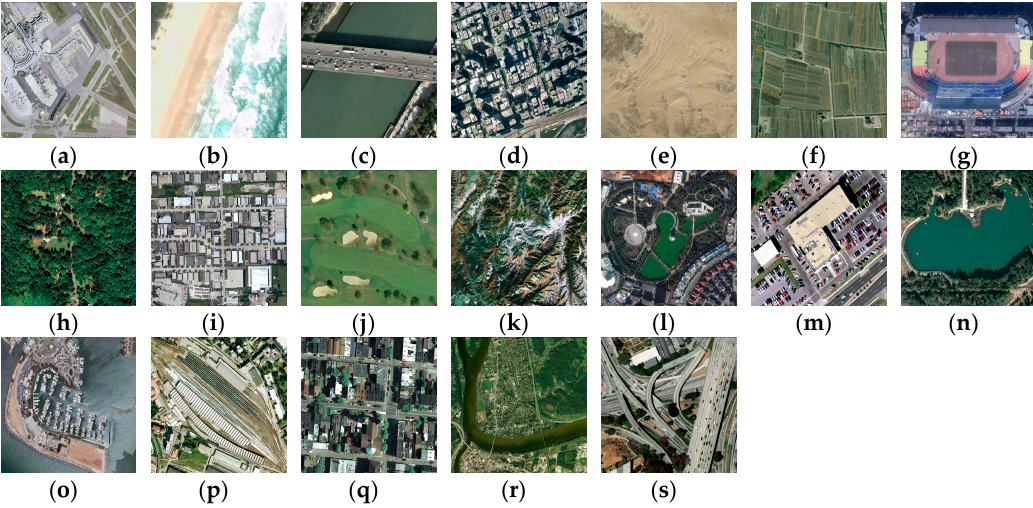
Figure 9. One example image for each class of the WHU-RS Dataset: ( a ) Airport; ( b ) Beach; ( c ) Bridge; ( d ) Commercial; ( e ) Desert; ( f ) Farmland; ( g ) Football field; ( h ) Forest; ( i ) Industrial; ( j ) Meadow; ( k ) Mountain; ( l ) Park; ( m ) Parking lot; ( n ) Pond; ( o ) Port; ( p ) Railway; ( q ) Residential; ( r ) river; and ( s ) Viaduct.